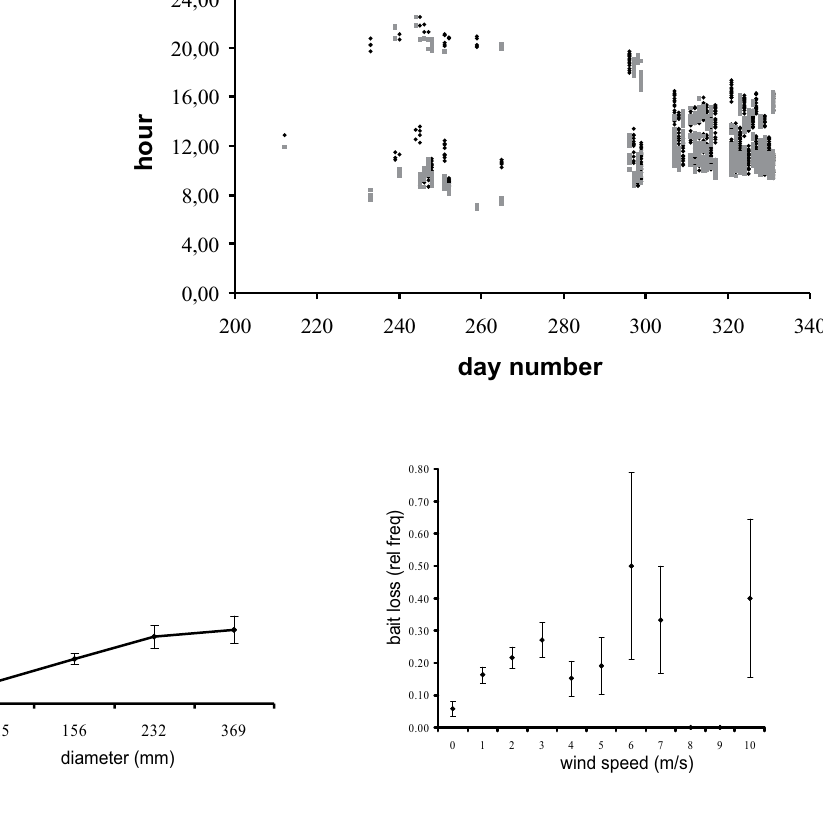
Fig. 6 . Rela - tive frequency of missing bait in the buoy experiment in relation to (a) buoy diameter and (b) wind speed (SE indicated by vertical bars).